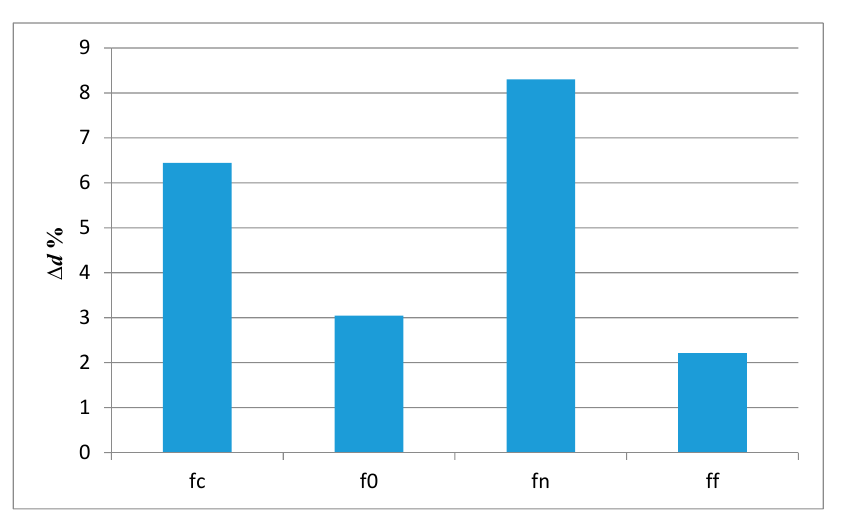
17 of 20 Figure 19. Sensitivity of diameter reduction vs. f f .